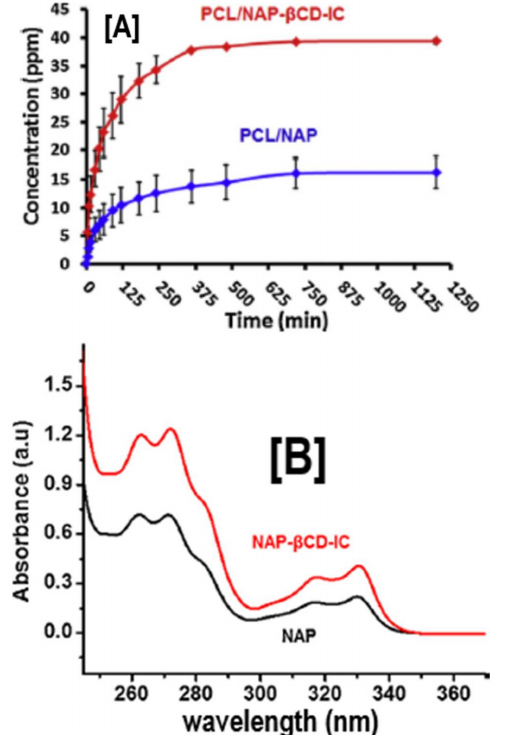
Figure 6. The release and solubility profiles of naproxen (NAP) from PCL and PCL/ β -CD-IC nanofibers. The release profile study ( A ) by HPLC revealed significant release of NAP from PCL/NAP- β -CD-IC, compared to the PCL/NAP nanofibers, owing to improved solubility of encapsulated NAP, compared to pristine NAP. These results were further corroborated by solubility analyses (UV-vis) ( B ), which showed significantly enhanced solubility, as observed by increases in the intensity. Images adapted and reproduced from [63]. Copyright Elsevier Ltd.,